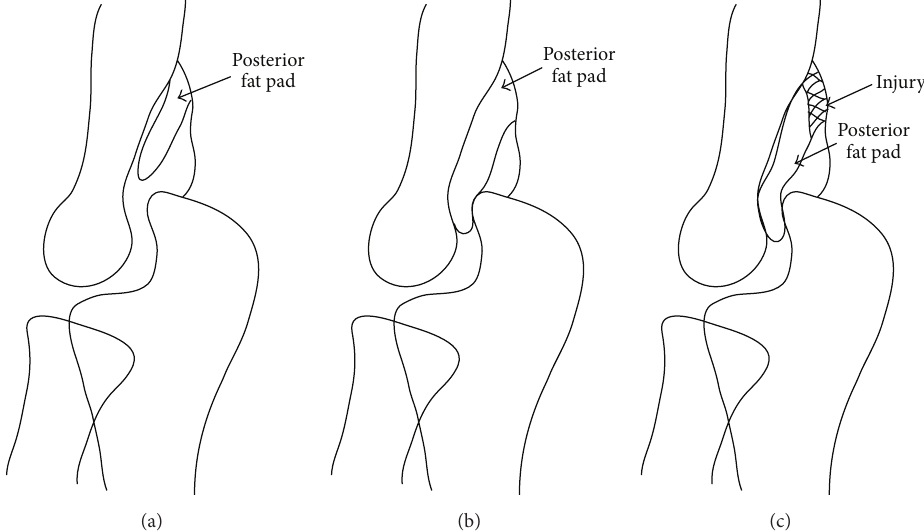
Figure 3: Schematics of the posterior fat pad. (a) Posterior fat pad at the olecranon fossa in the normal elbow. (b) The hypertrophied posterior fat pad in the present case was interposed between the olecranon and olecranon fossa. (c) The posterior fat pad, hanging low at the triceps, was evident in the left elbow in the present